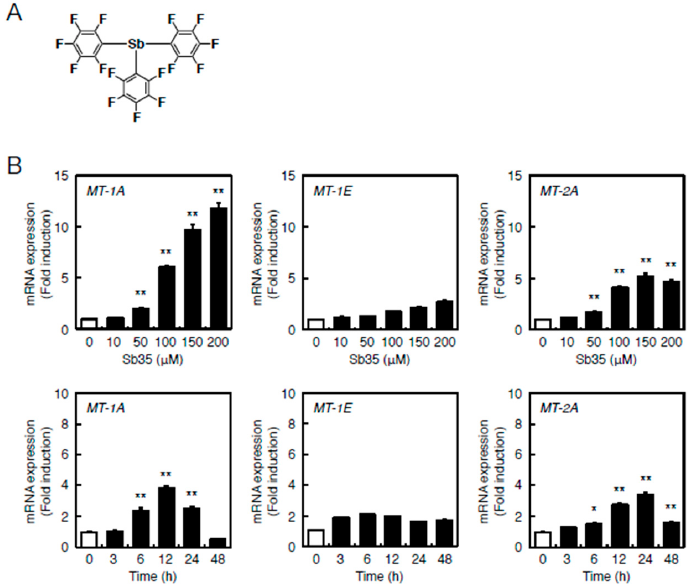
Figure 2. Sb35-induced transcription of endothelial MT-1A , MT-1E , and MT-2A . ( A ) Structure of Sb35; ( B ) Sb35-induced transcription of MT. Vascular endothelial cells were incubated with or without 10, 50, 100, 150, or 200 µM Sb35 for 12 h ( upper panels) or 100 µM Sb35 for 3, 6, 12, 24, or 48 h ( lower panels). MT-1A , MT-1E , and MT-2A mRNA expression was determined by performing real-time RT-PCR. Data are expressed as the mean ± SE of three representative samples, with each sample obtained from three independent experiments. * p < 0.05 and ** p < 0.01 indicate significantly different from the corresponding